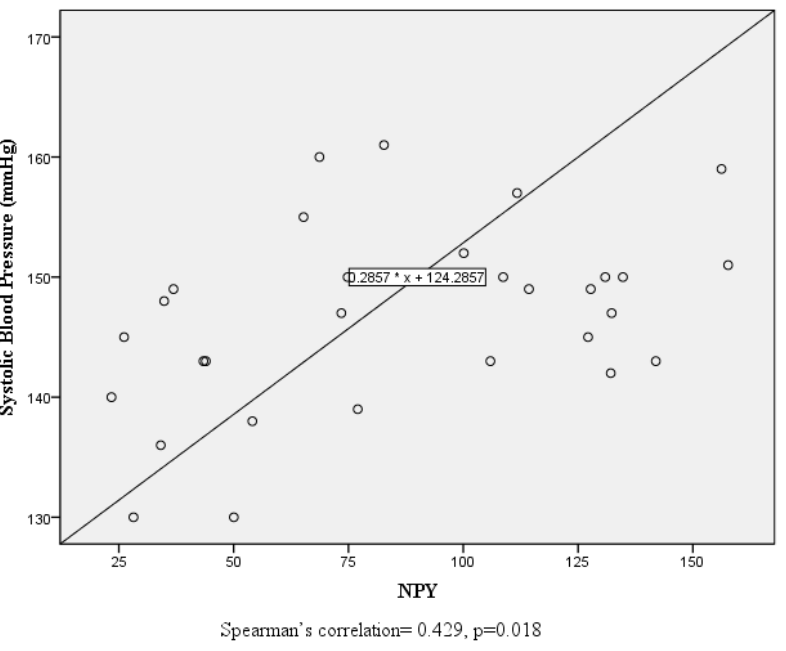
Figure 2. Scatter plot and correlation between systolic blood pressure and serum neuropeptide Y levels post intervention.